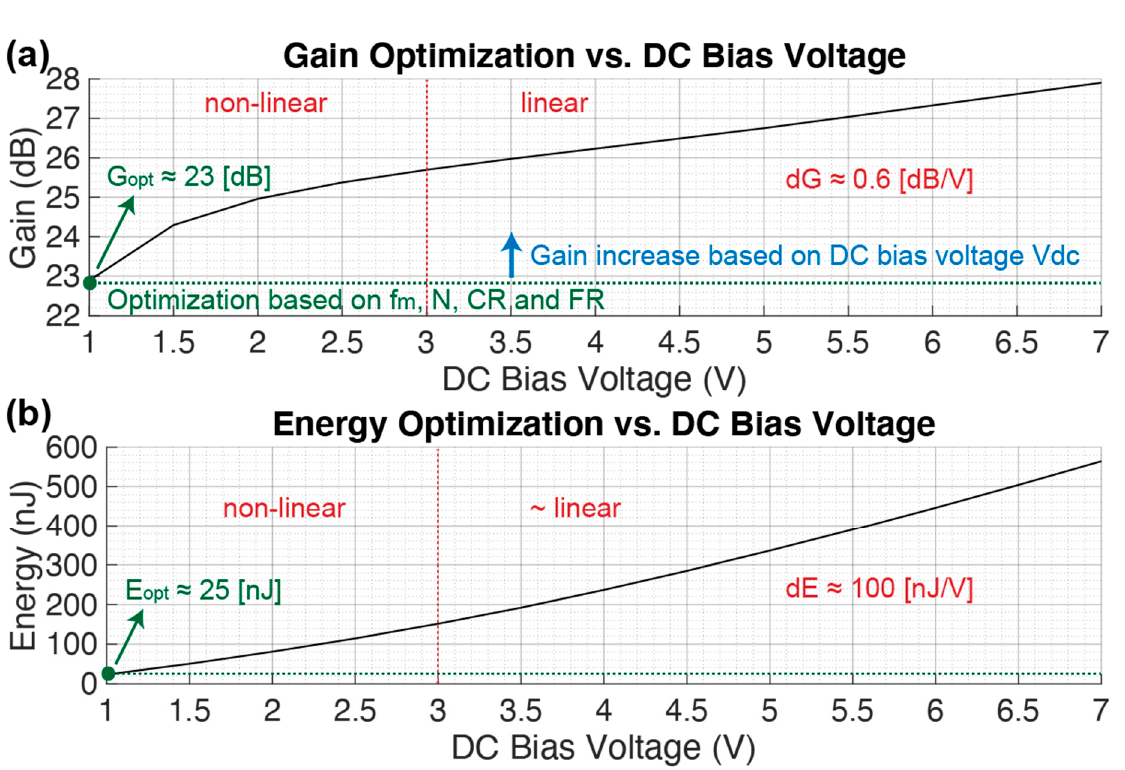
Figure 10. High performance gain ( a ) and energy ( b ) consumption based on the DC biasing voltage Vdc of the LC tank filter. The remaining values are maintained constant as in Table